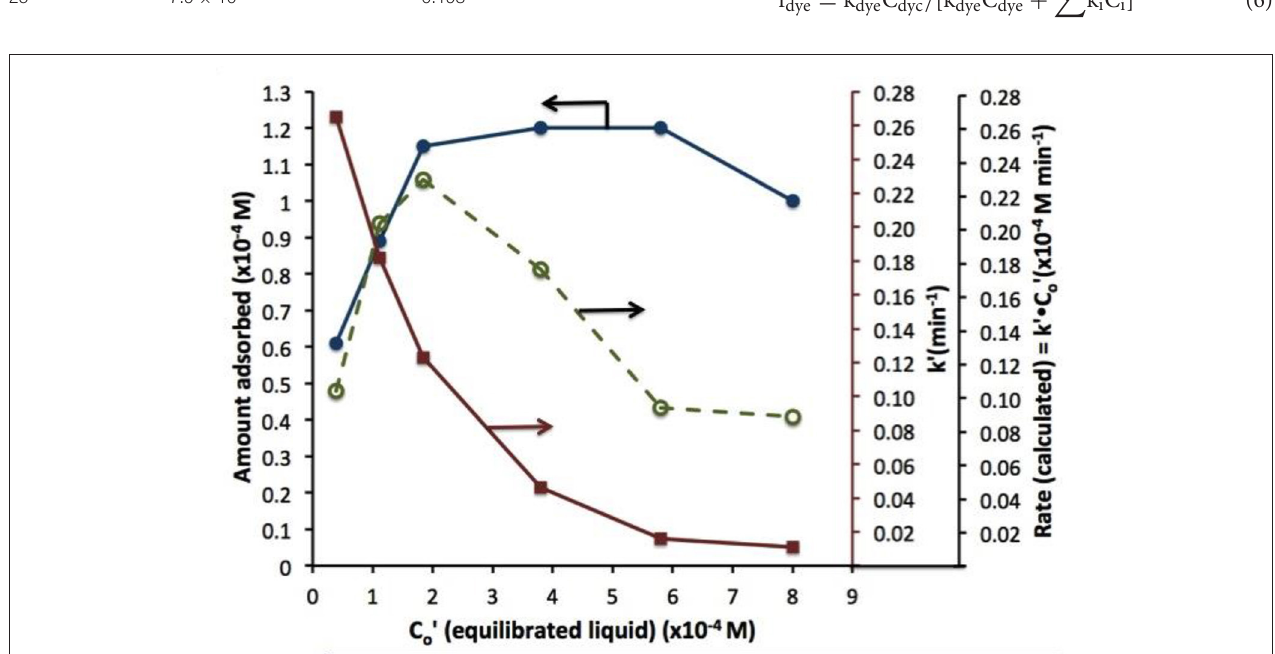
FIGURE 5 | Dye absorbed (left axis), rate constant k’(closed circles), and rate (calculated) vs. equilibrated liquid phase dye concentration (open circles). Beyond 2 10 − 4 M dye, the coverage is complete; eventual rate decline at higher Co is likely due to photon absorption by dye.